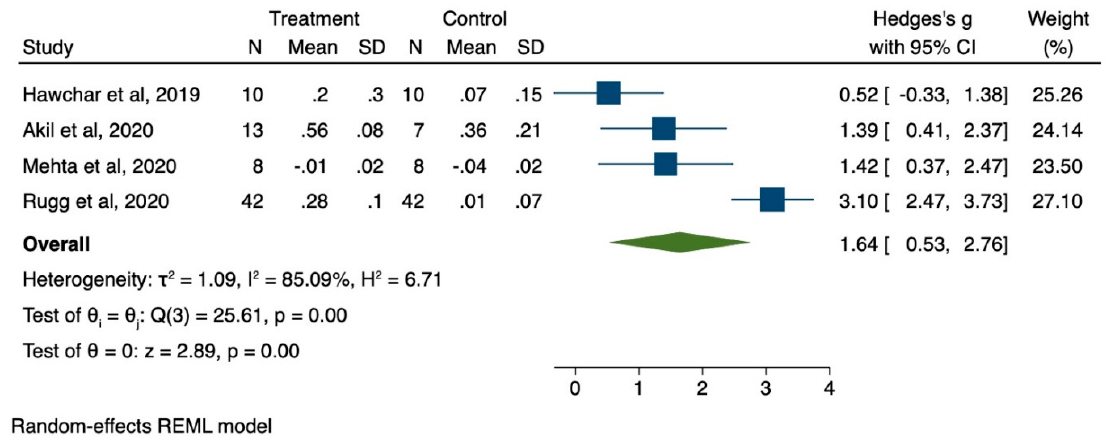
Figure 4. Forest plot for efficacy of CS therapy to reduce NE requirements at 24 h.